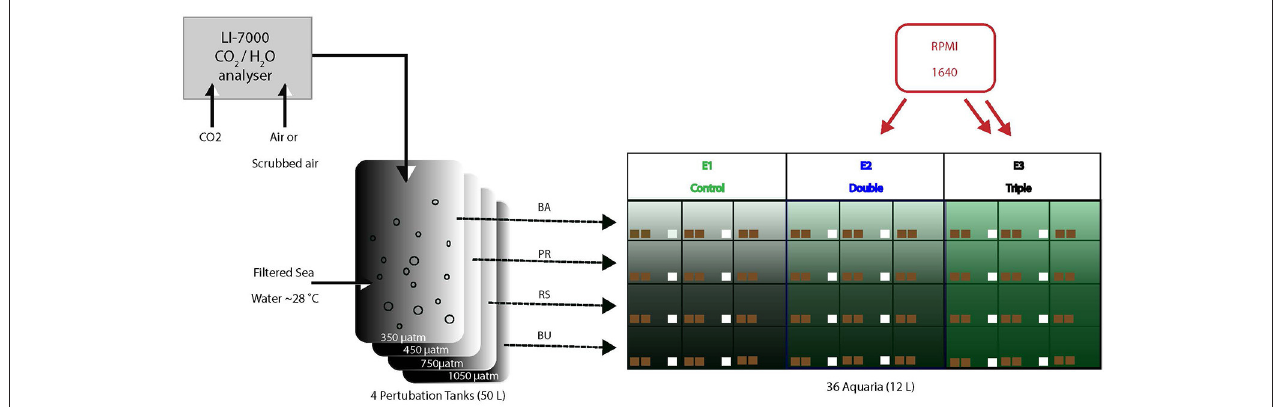
FIGURE 1 | Experimental setup consisting of four large barrels in which the p CO 2 (4 levels) is manipulated and controlled through a central CO 2 sensor. From every barrel, water is pumped into 9 aquaria (12 L each). Of these 9, two groups of 3 aquaria were supplied with additional dissolved organic carbon (E1: green, E2: blue, E3: black) using peristaltic pumps. Pumps ran at different speed between E2 and E3 to deliver different concentration of RPMI. Each of the 36 aquaria contained 2 sponge bearing coral cores (brown squares) and 24 aquaria contained control cores (white